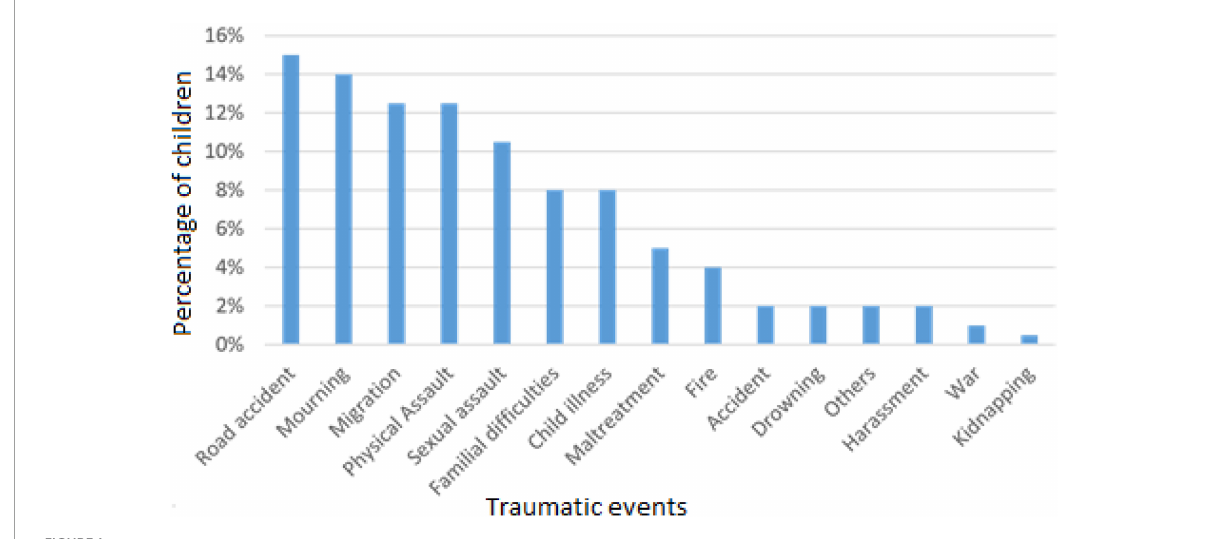
FIGURE1 Other kinds of trauma from 2017 to 2019 ( N =